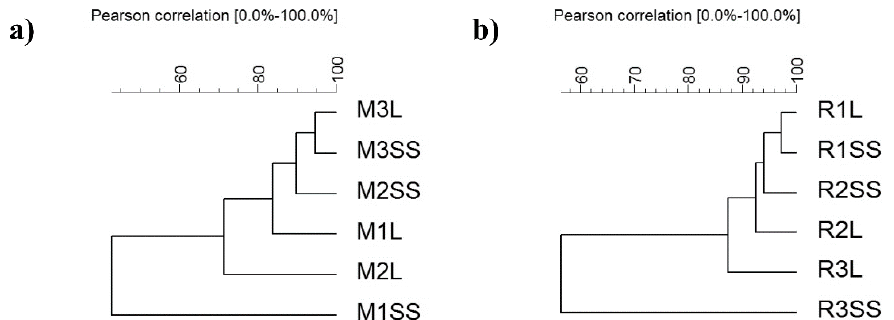
Figure 3. Dendrogram of general distribution of bacterial composition of communities between treatments in ( a ) M. spicata and ( b ) R. officinalis (M1SS: M. spicata composed sample, time 1,